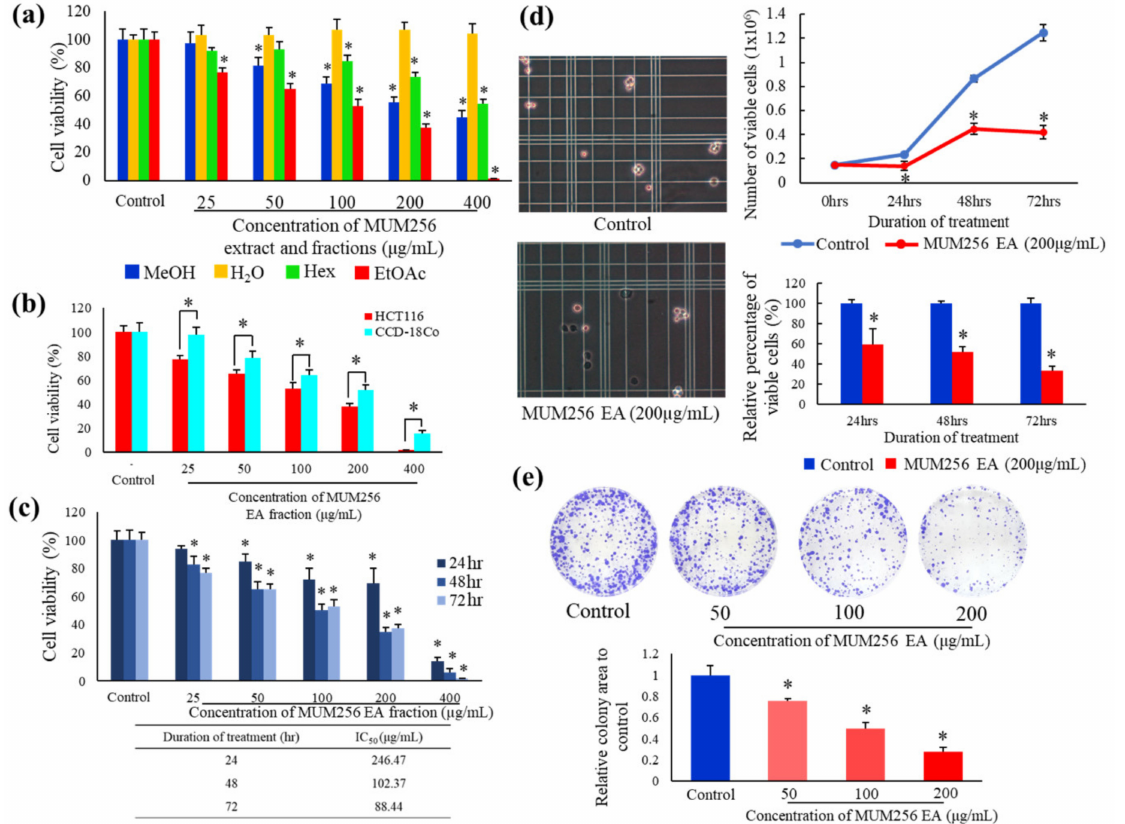
Figure 3. Cytotoxic and antiproliferative properties of MUM256 EA against HCT116 cells. ( a ) Cytotoxic e ff ect of MUM256 crude extract (MeOH: methanol) and 3 di ff erent fractions (H 2 O: water; Hex: hexane; EtOAc: ethyl acetate) against HCT116 cells at a series of concentrations after 72 h treatment, ( n = 4, * p < 0.05). ( b ) The toxicity of MUM256 EA towards CCD-18Co as compared to its cytotoxicity against HCT116 after 72 h exposure, ( n = 4, * p < 0.05). ( c ) Cytotoxic e ff ect of MUM256 EA at a series of concentrations against HCT116 cells after 24, 48 and 72 h of exposure, ( n = 4, * p < 0.05). ( d ) Line graph shows the inhibitory e ff ect of MUM256 EA fraction on HCT116 cells. Bar graph illustrates the relative percentage of number of viable cells after exposure to MUM256 EA fraction after normalized to 100% for number of viable cells exposed to vehicle control (0.5% dimethyl sulfoxide (DMSO)) ( n = 3), * p < 0.05 indicates significant di ff erence between the untreated and the treated cells. ( e ) Images of colony formation after 7 days of control and MUM256 EA pre-treated cells in 6 well-plate. Crystal violet staining was used for visualization and quantification of colonies. The area of colonies formed are shown as bar graph with the mean relative mean colony area to control ± standard deviation (SD) ( n = 3, * p <